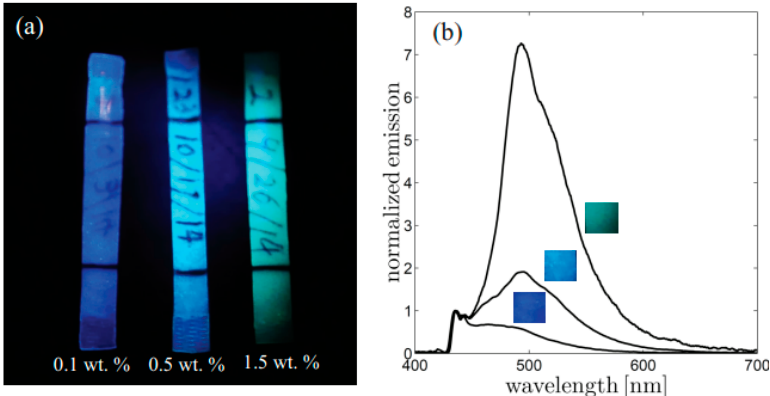
Figure 10. ( a ) Photographic image of three TPU-BBS samples with concentrations 0.1, 0.5, and 1.5 wt.%. The image is obtained through a commercial linear plastic polarizer. ( b ) Fluorescence spectra